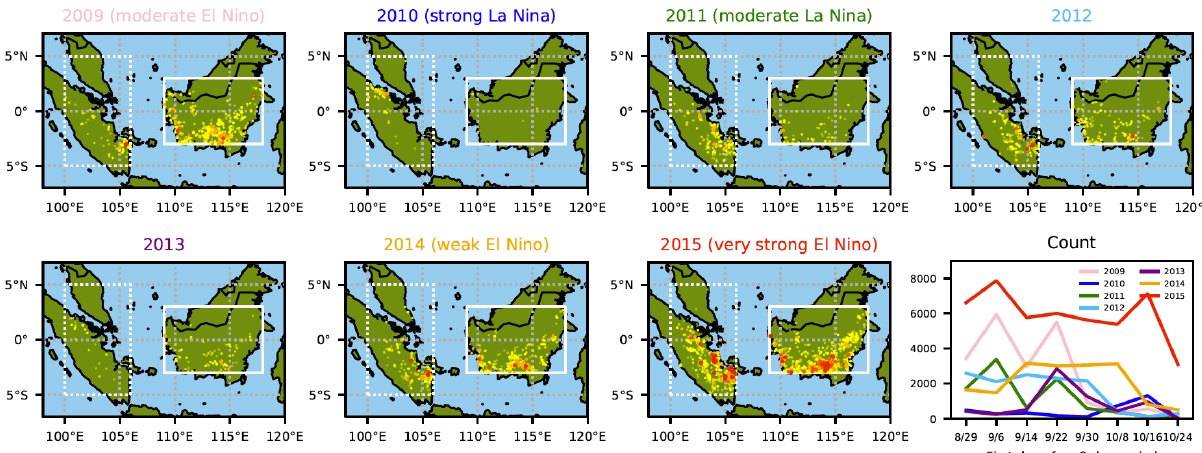
Figure 3. Number of fires (with high confidence) within the rectangles according to 1km MODIS 8d fire data (MOD/MYD14A2); yellow represents 2–3 counts, orange 4–5 counts, and red > 5 counts (the maximum is 16, as Terra and Aqua are counted separately for 8 time frames within September–October). The lower right panel shows the total pixel counts of fires with high confidence within the rectangles.